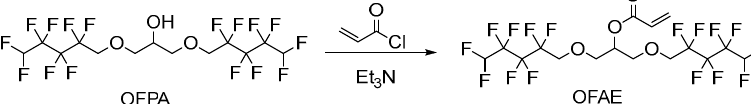
Molecules 2023 , 28 , x FOR PEER REVIEW